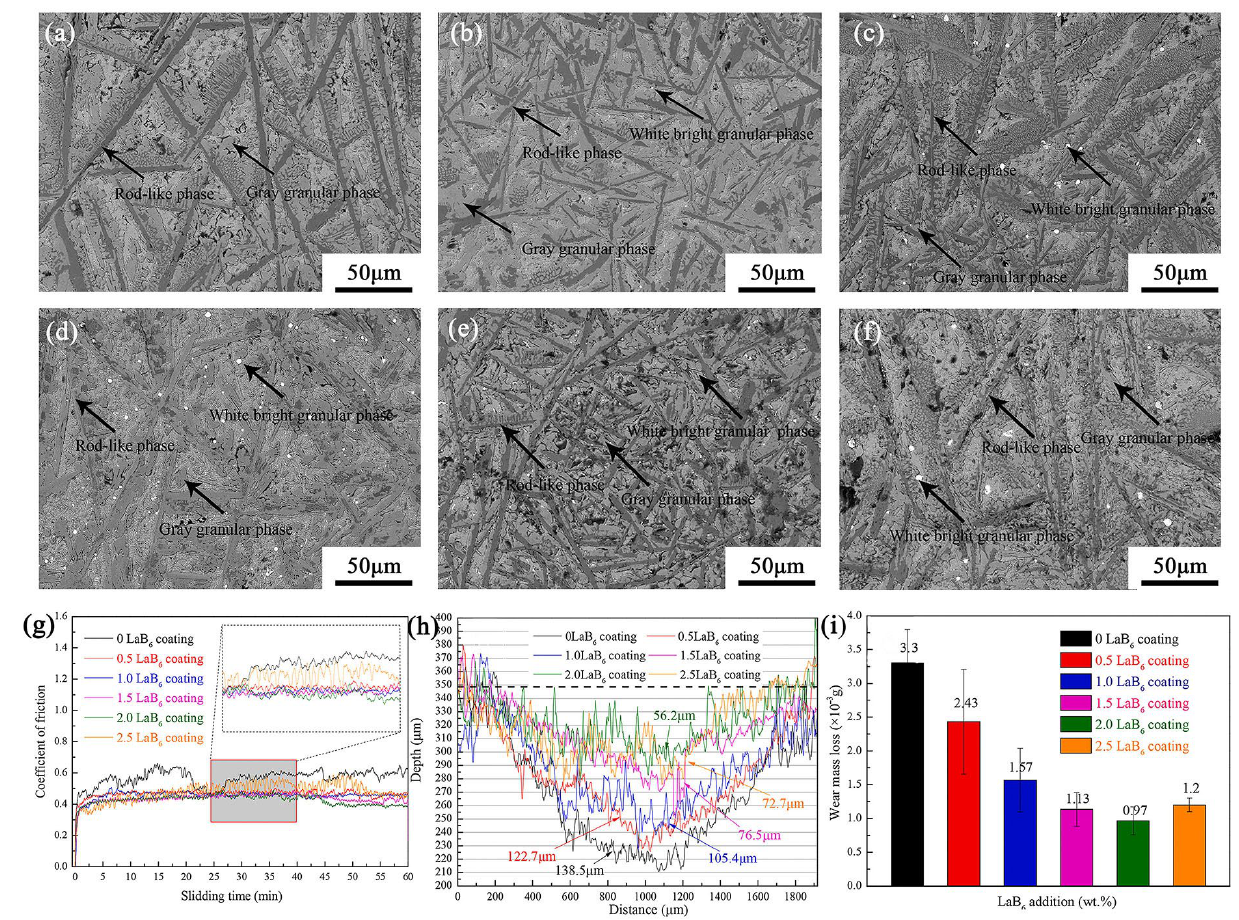
Figure 10. SEM images of the microstructure in the upper area of each coating: ( a ) without LaB 6 addition, ( b ) 0.5 LaB 6 addition, ( c ) 1.0 LaB 6 addition, ( d ) 1.5 LaB 6 addition, ( e ) 2.0 La 6 addition, ( f ) 2.5 LaB 6 addition, ( g ) friction coefficient of the cladding coatings with different LaB 6 additions, ( h ) wear depth of the cladding coatings with different LaB 6 additions, and ( i ) wear loss of the cladding coatings with different LaB 6 additions (Reprinted from Ref. [146] with the kind permission of Elsevier).